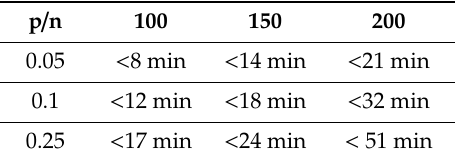
Table 7. Processing time in Test IV with